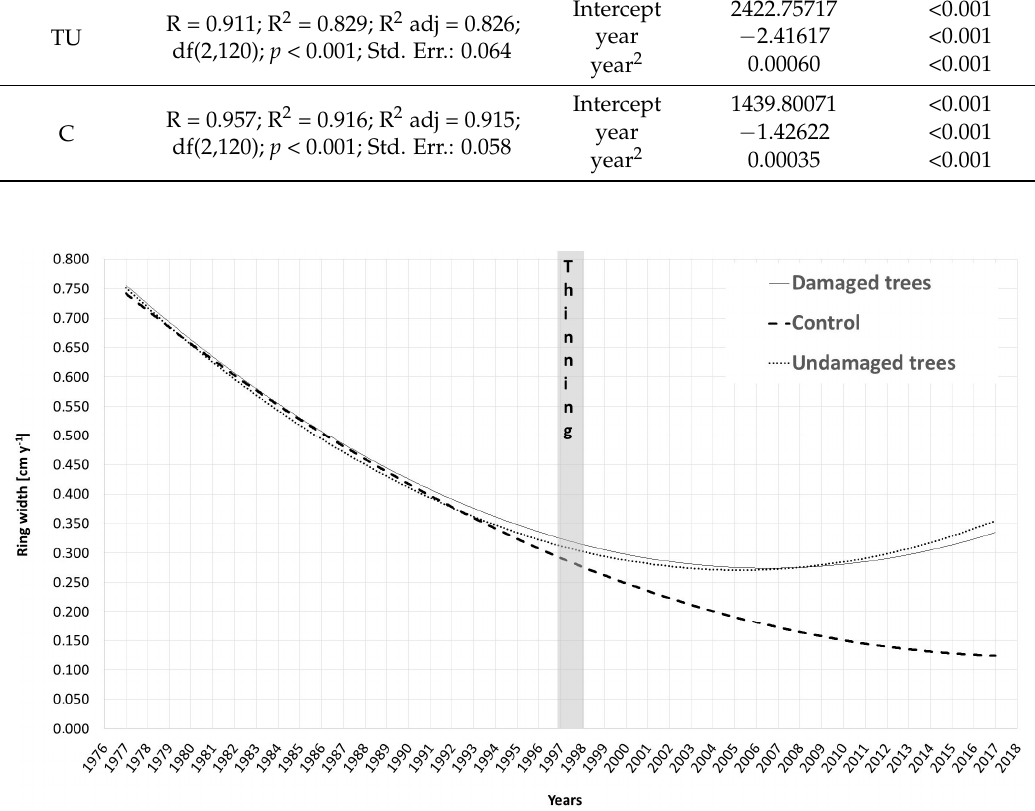
Figure 2. Polynomial regression of weighted yearly ring width (YWW) (i.e., the mean of yearly ring width weighted on the basis of the frequency distribution of trees per each diameter class in 2017) from ‘70s to 2017. The non-linear regression analysis results are shown in Table 8.